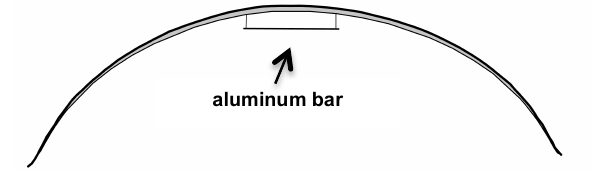
Fig. 4: Cross-section of the wing showing position of the aluminum bar defining the